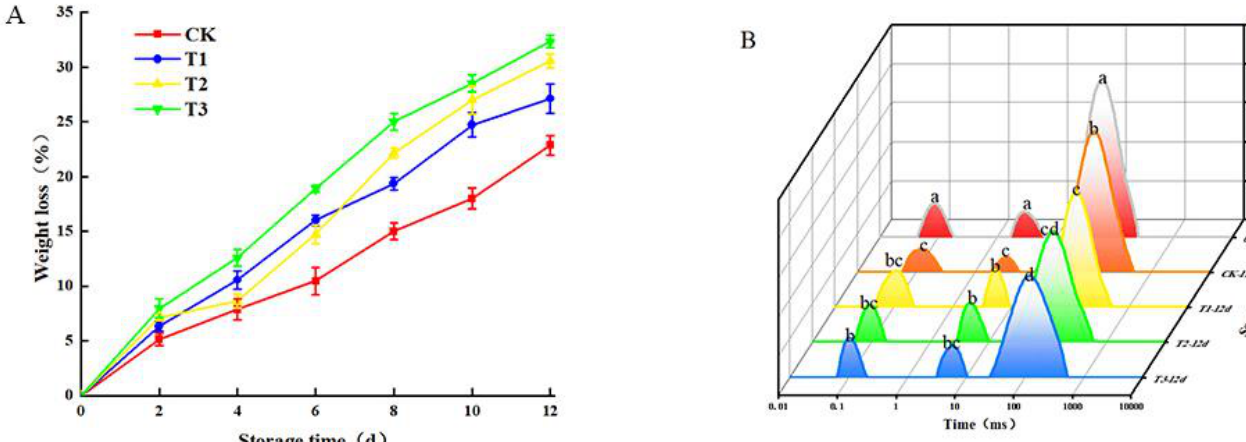
Figure 4. Changes in weight loss ( A ) and moisture migration ( B ). The means with different lowercase letters (a–c) in figure differ significantly ( p < 0.05).